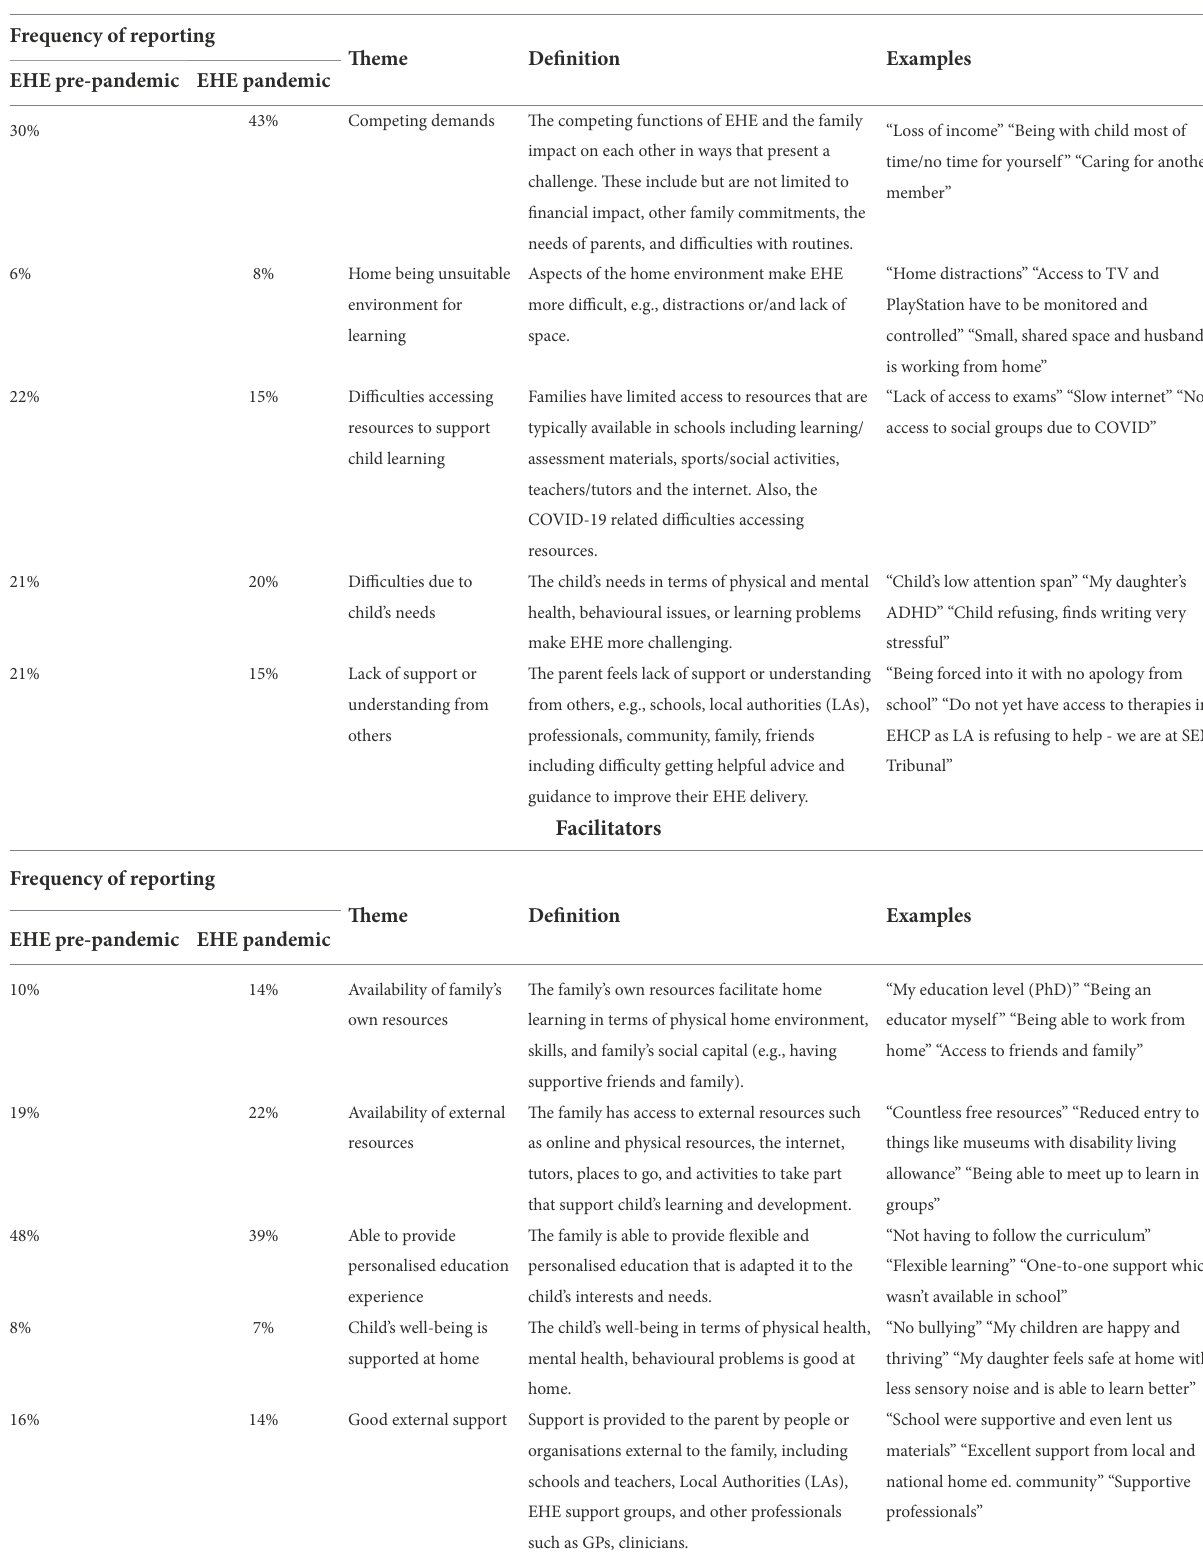
TABLE 5 Barriers and facilitators of Elective Home Education as reported by parents in this